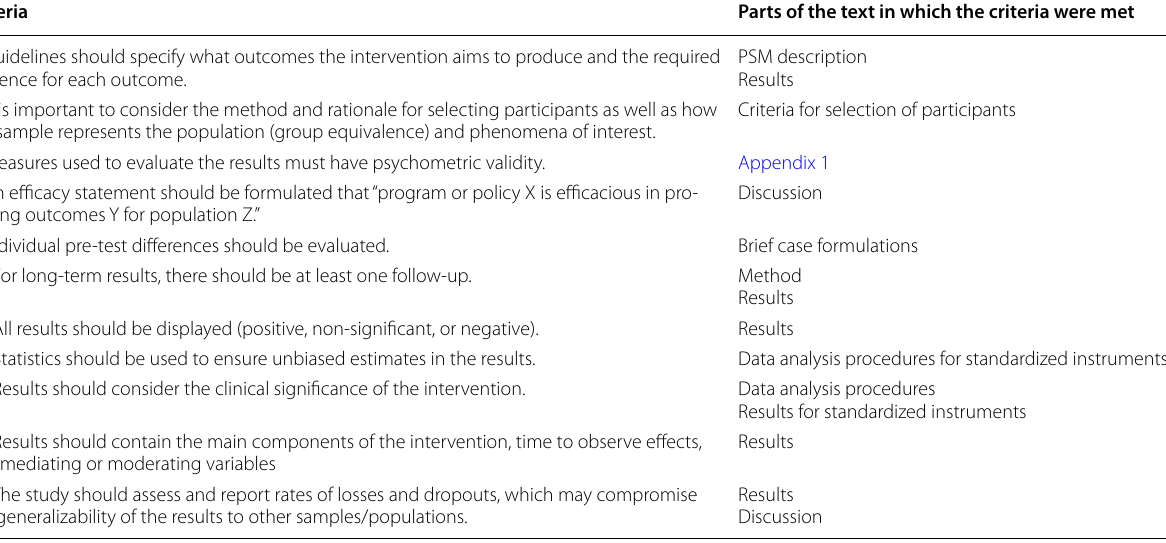
Criteria translated from Durgante and Dell’Aglio (2018)